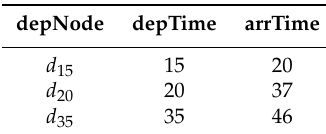
( S = { bus , train } ) includes the most important B , M A